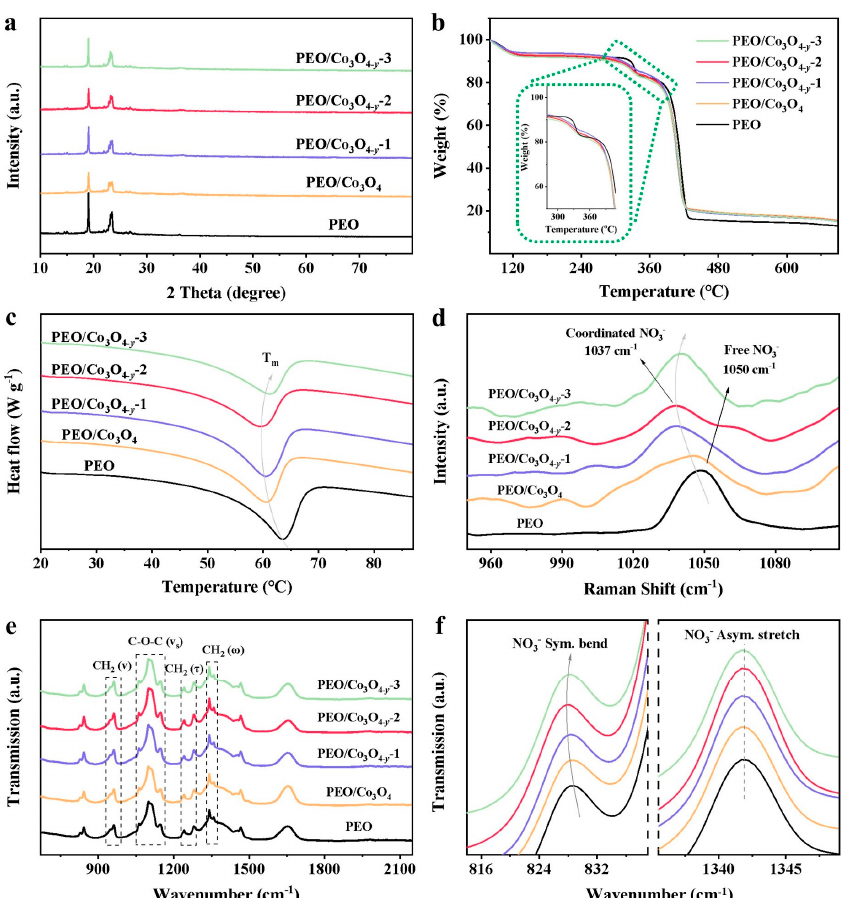
Figure 3. Characterizations of the electrolyte films. ( a ) XRD pattens, ( b ) TGA curves, ( c ) DSC curves, ( d ) Raman spectra, and ( e , f ) FTIR spectra of PEO, PEO/Co 3 O 4 and PEO/Co 3 O 4- y − x ( x = 1, 2 and 3) electrolyte fi lms.